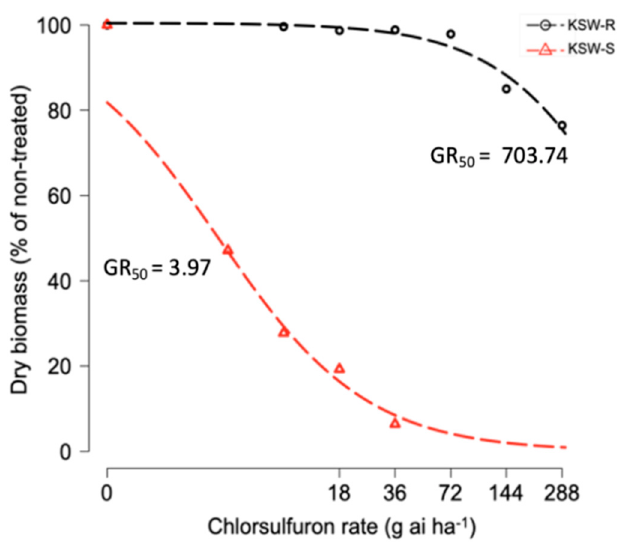
Figure 2. Chlorsulfuron dose-response curves obtained by three parameter log-logistic regression. 𝑌 = { (cid:3031) + exp[𝑏(𝑙𝑜𝑔𝑥 − 𝑙𝑜𝑔𝑒(cid:4667)(cid:4671)(cid:4669) analysis of above-ground dry biomass of KSW-R (resistant) and KSW-S (susceptible) wild buckwheat at 3 weeks after treatment; GR 50 herbicide rate required for 50% growth reduction.